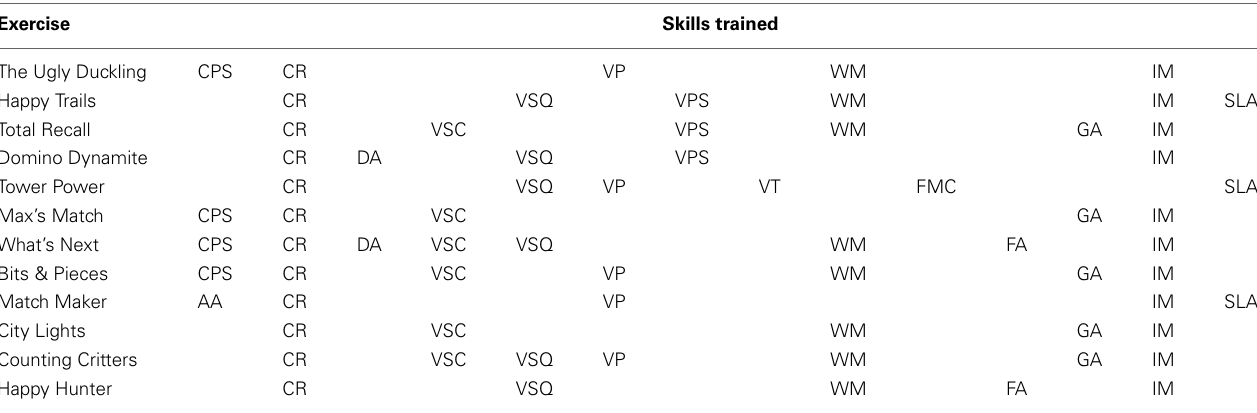
Table 1 | Cognitive skills trained by